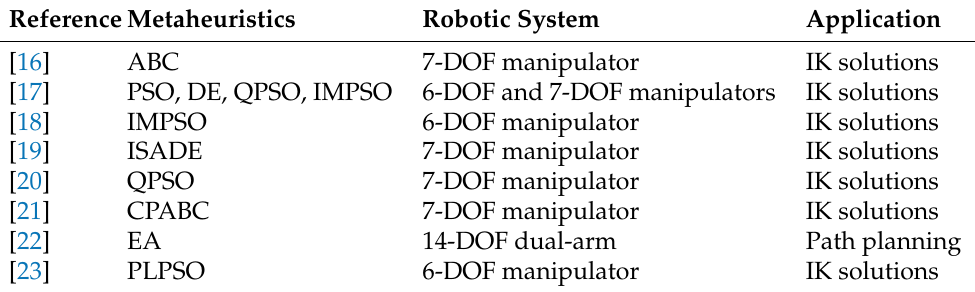
Table 1. State-of-the-art literature review. IK means inverse kinematics. Reference